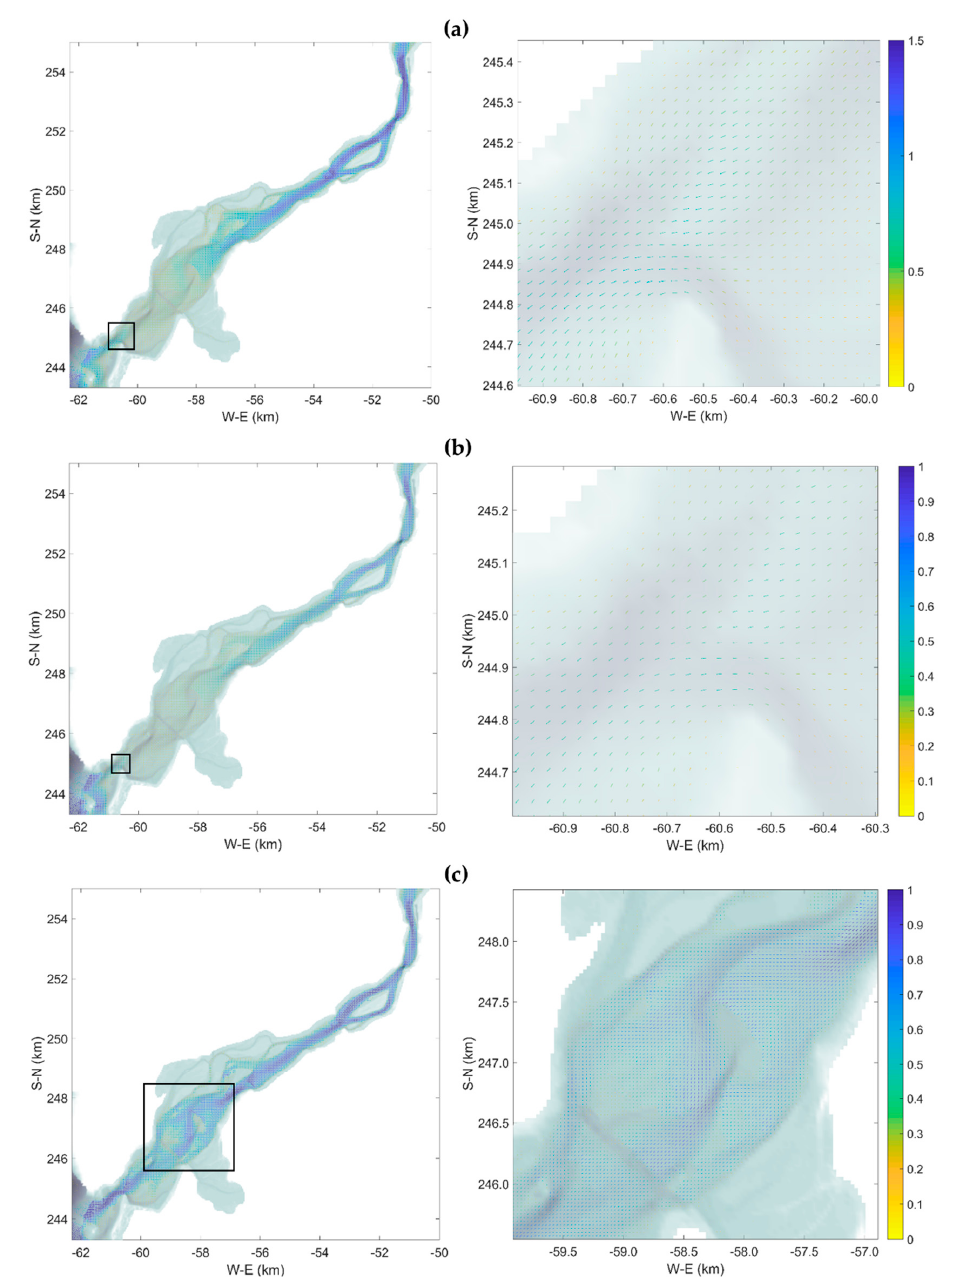
Figure 9. Scenario S3: velocity patterns and magnitude (in m · s − 1 ). ( a ) Flow rate ~3000 m 3 · s − 1 and tidal level + 0.80 m; ( b ) flow rate ~1000 m 3 · s − 1 and tidal level + 1.00 m; and ( c ) flow rate ~1000 m 3 · s − 1 and tidal level − 1.10 m.